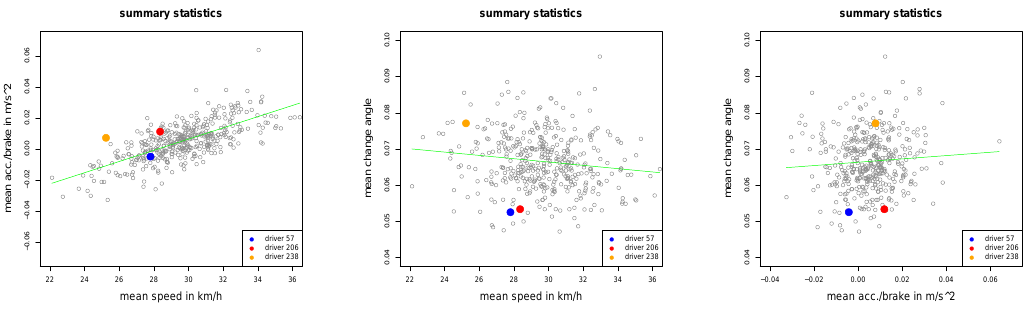
Figure 2. Summary statistics v , a and ∆ of all n = 416